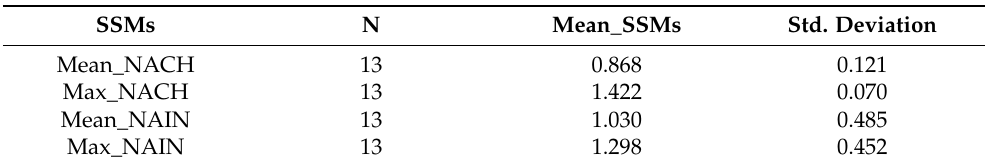
Table 4. Mean/max. NACH and mean/max. NAIN measures of the 13 cases of the selected historic Chinese towns and